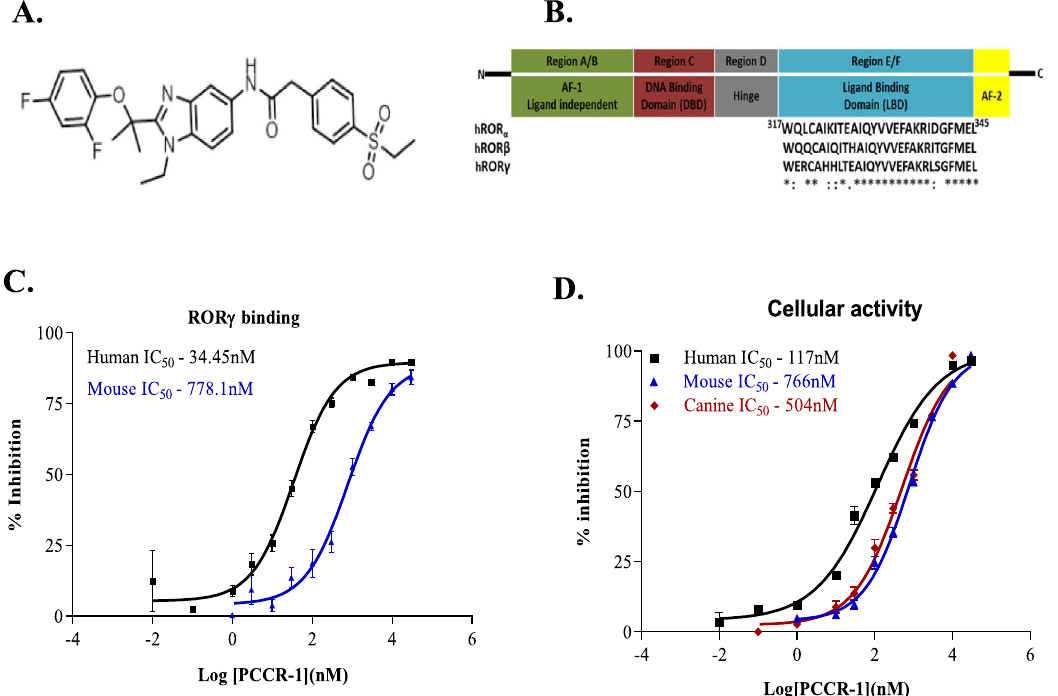
Figure 1. PCCR-1 inhibits RORγ both biochemical and cellular across species. Biochemical and cellular activity of RORγ inhibitor. ( A ) Chemical structure of PCCR-1. ( B ) Functional domains of ROR. Schematic diagram of domain structure of RORs with a N-terminal ligand-independent activation function 1 (AF-1) domain, followed by a DNA binding domain (DBD), a hinge domain, and a ligand-binding domain with an activation function 2 (AF-2) domain. Sequence alignment of the ligand binding domain of human RORα, RORβ, and RORγ performed using 56 methodology. Identical and partially conserved residues are labeled with an asterisk and colon respectively. ( C ) Biochemical activity. Effect on cofactor recruitment to the human (n = 15) and mouse (n = 6) RORγ LBD measured by TR-FRET assay. ( D ) Cellular activity. Dose dependent inhibition of IL-17 production from human PBMC (n = 24), mouse splenocytes (n = 13) and canine PBMC (n = 6). ‘n’ is the representative of number of experimental replicates. (The human, mouse and canine basal values were in the range of 58.41 pg/ml, 9.24 pg/ml and 1.5 pg/ml, on induction the IL-17 values were in the range of 1600 pg/ml, 746 pg/ml and 1503 pg/ml